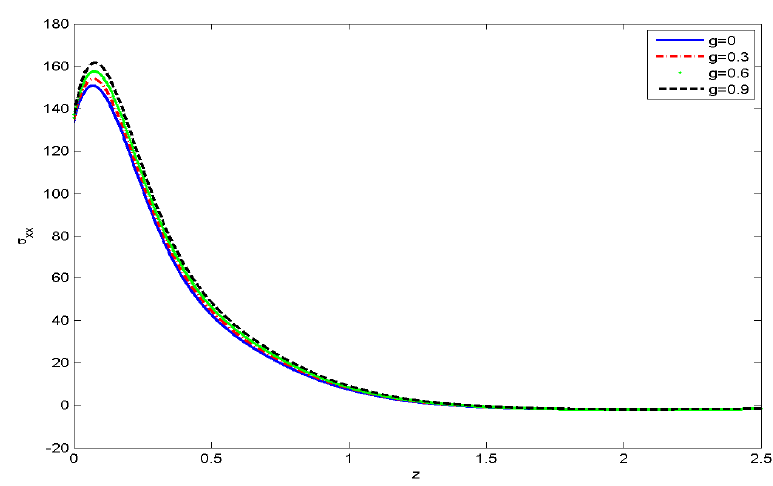
Figure 28. Normal stress σ xx concerning z with gravity g.